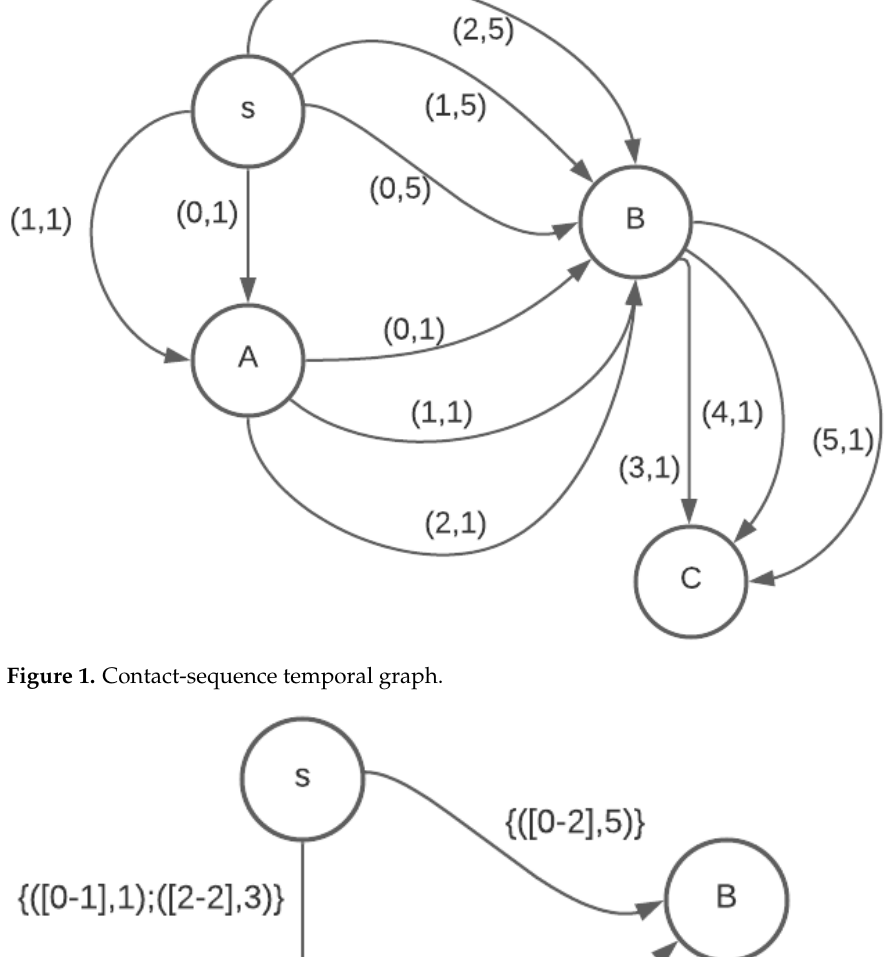
Figure 1. Contact-sequence temporal graph.